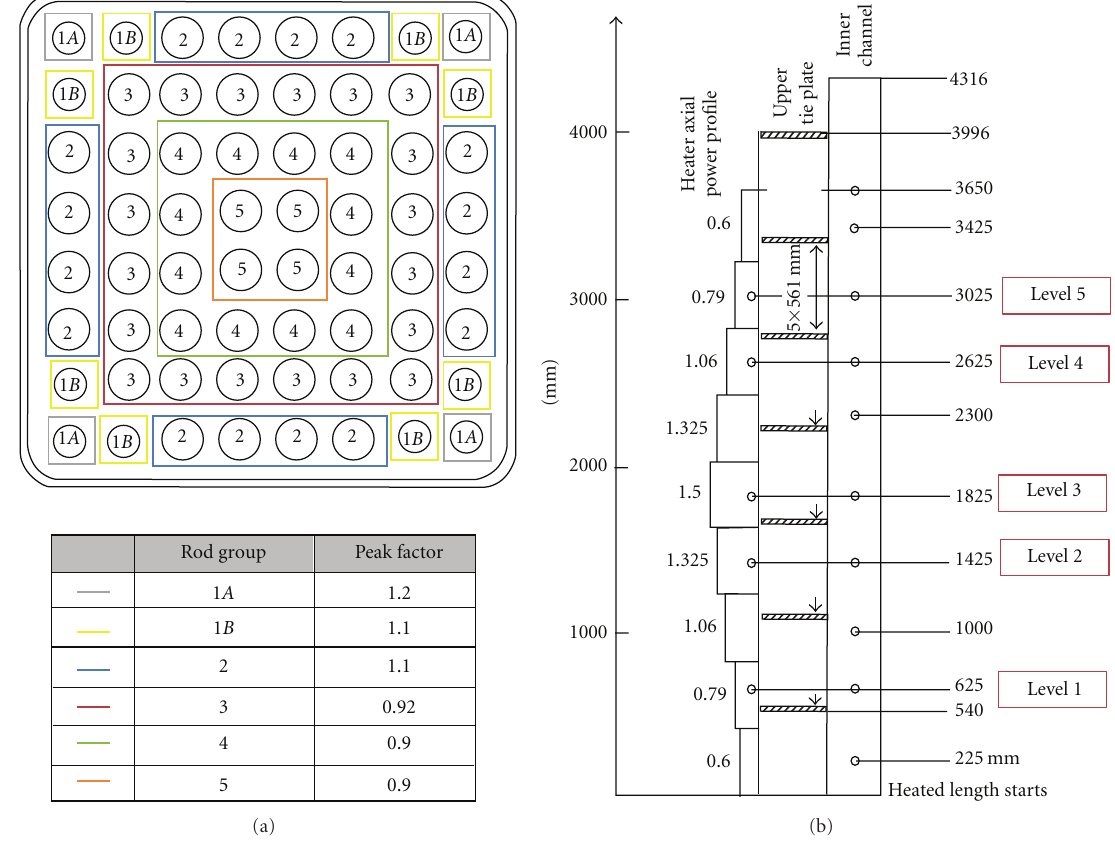
Figure 4: Internal rod- to-rod power distribution (a) and axial power shape (b).